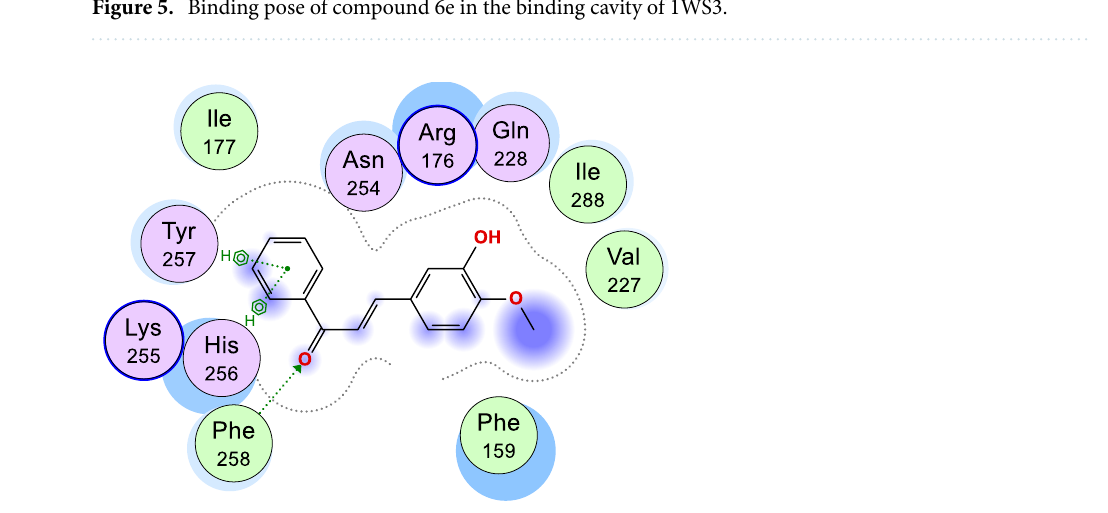
Figure 6. 2D representation of the binding interactions between compound 6e and the amino residues of 2VF5.